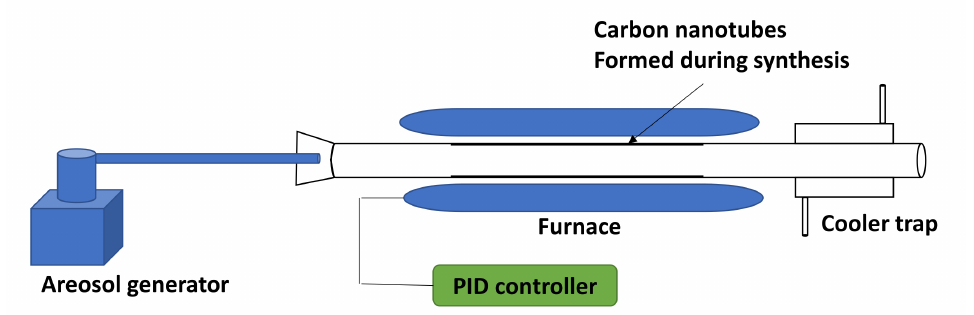
Figure 6. Scheme of the apparatus used during the CVD